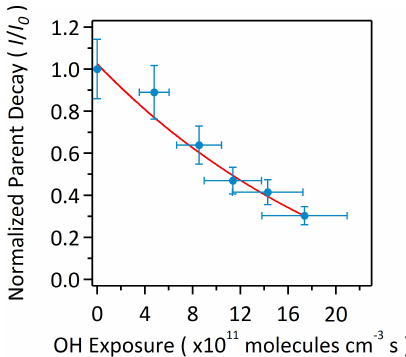
Figure 3. The normalized decay of α pOS-249 upon heterogeneous OH